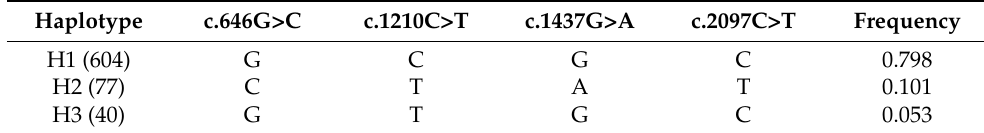
Table 4. Main haplotypes and their frequencies of CAST in Sonid